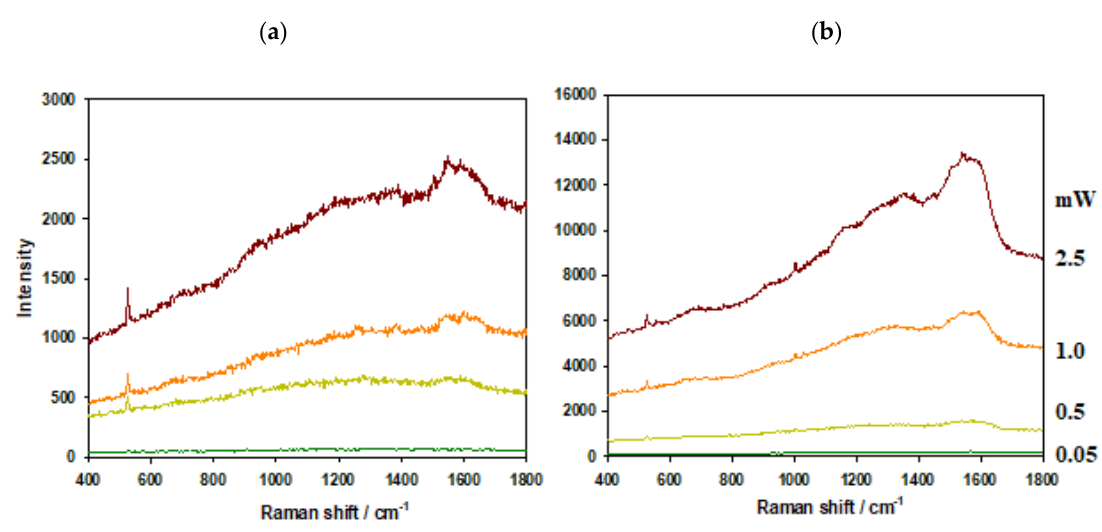
Figure 3. Bare substrates, ( a ) AuSiO 2 and ( b ) AuPS. Laser power at the sample from bottom to top: 0.05, 0.5, 1, 2.5 mW.